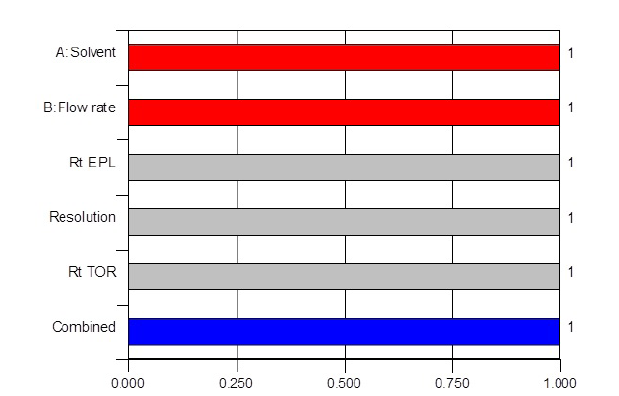
FIGURE 6 - Desirability function representation basis unity=1.